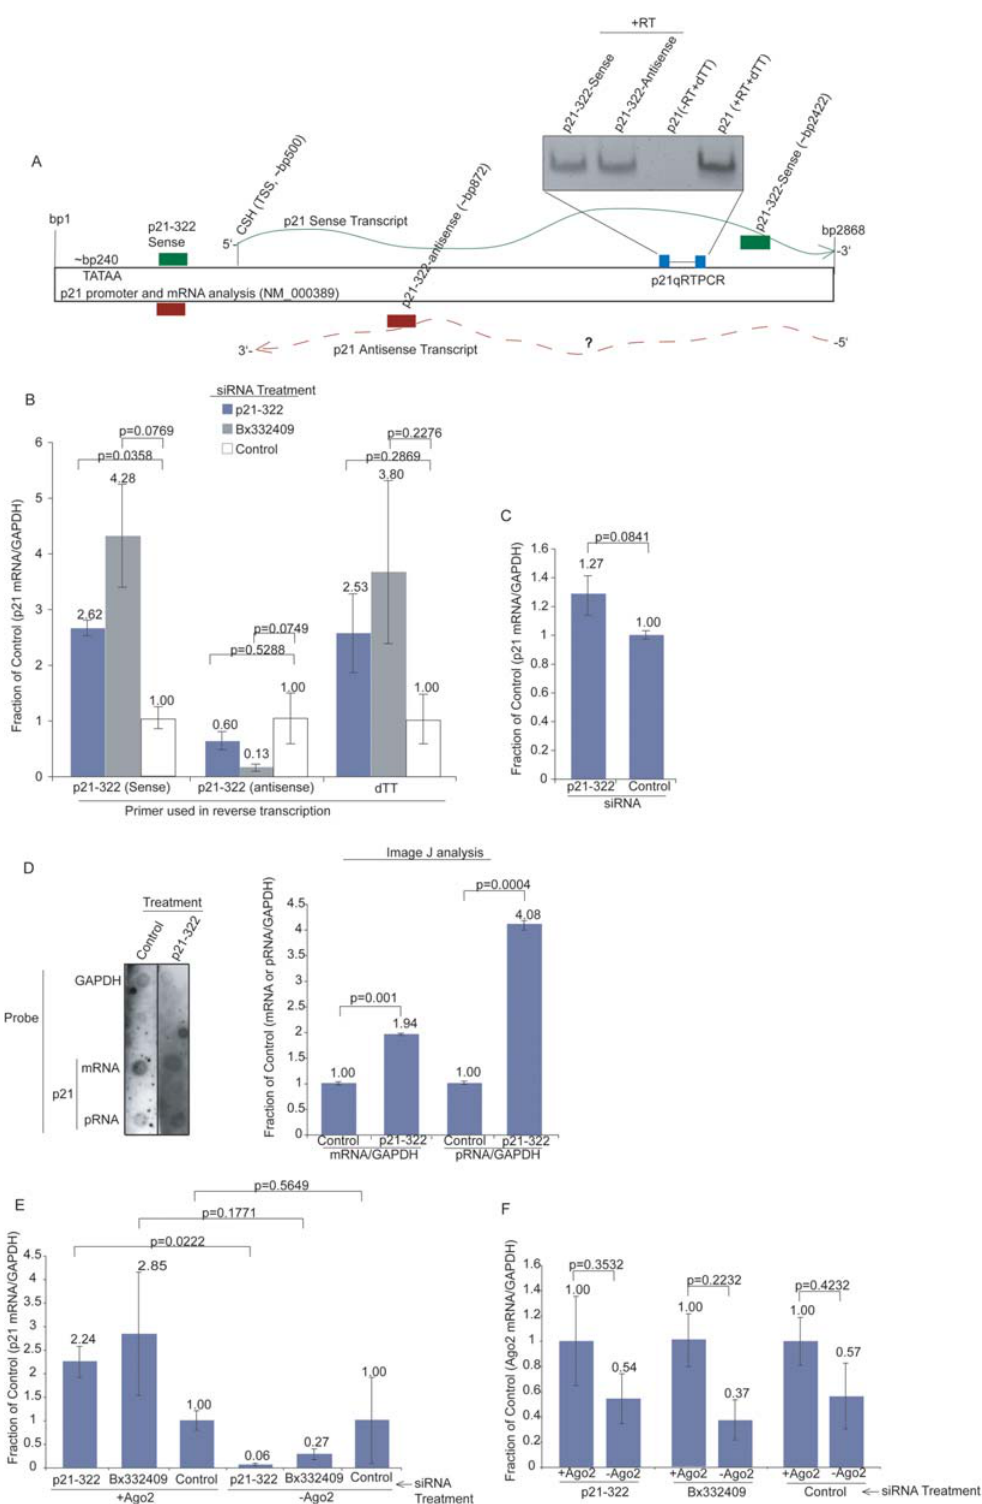
Figure 1. siRNA Targeting of the p21 Antisense Transcripts Results in Gene Activation of p21. (A) The p21-322 siRNA sequence can specifically reverse transcribe both sense and antisense p21 transcripts. The p21 promoter and mRNA are shown schematically. The transcriptional start site (TSS), p21-322 siRNA target site [5], and other regions where the p21-322 sense or p21-322 antisense strands can hybridize are shown. The hybridization of p21-322 sense or antisense was confirmed by primer specific cDNA conversion followed by RT-PCR specifically for p21 mRNA expression (inset). (B) Targeted suppression of the p21 antisense RNA, EST Bx332409 [14], results in pronounced p21 sense/mRNA expression. MCF-7 cells were transfected with siRNAs, p21-322, Bx332409, or R854 (Control) [3] and contrasted 48 hrs later. The averages of triplicate transfected cultures pooled together are shown with the standard deviations based on qRT-PCR analysis performed in triplicate for each sample along with the p values